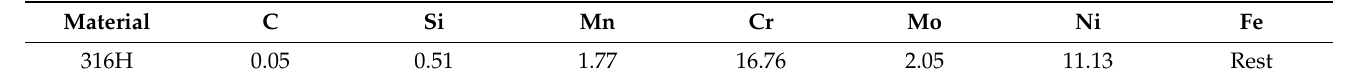
Table 1. Chemical composition in wt.% of the investigated 316H